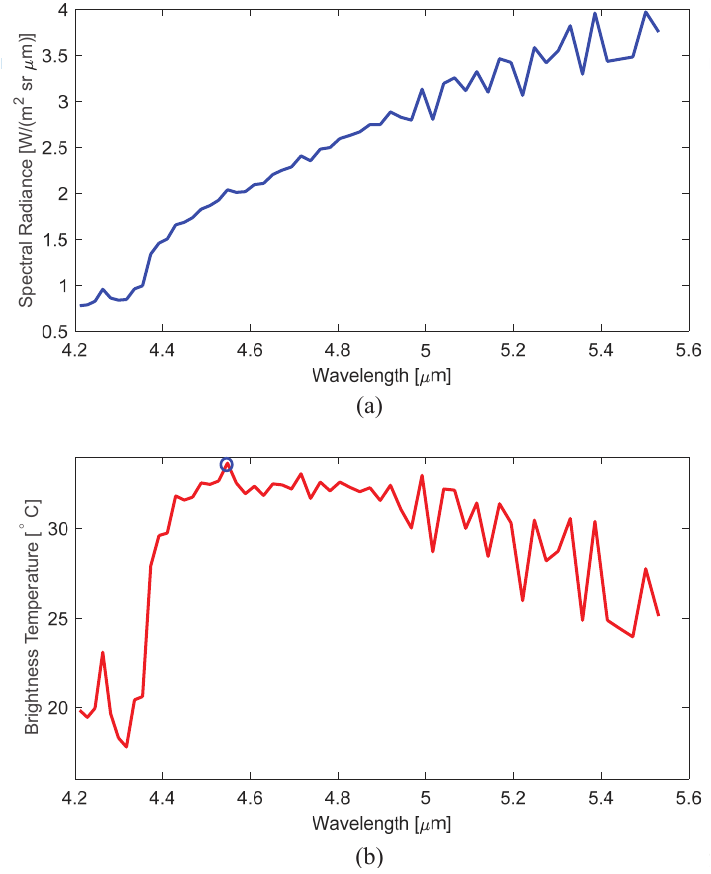
Figure 6. Example of brightness temperature extraction from spectral radiance: ( a ) the observed sample spectral radiance [W/(m 2 sr µ m)], and ( b ) the converted brightness temperature [ ◦ C]. T air separation module: According to the MODTRAN simulation in the MWIR band, the spectral transmittance of the carbon dioxide (CO 2 ) band (4.20–4.35 µ m) decreases abruptly with distance [21]. The average transmittance in the CO 2 band is 0.13, 0.03, 0.005, 0.0001, and 0 at 5 m, 10 m, 20 m, 50 m, and 100 m, respectively. Figure 7 demonstrates the atmospheric transmittance at the 50 m distance in the upper MWIR band. Note that the atmospheric transmittance is 0.0001 in the CO 2 absorption band. If we consider only the CO 2 band ( λ CO = [4.20–4.35 µ m]) with a minimum 20m object distance, transmittance 2 ) can be regarded as 0, which leads to Equation (7) derived from Equation (5). τ ( λ CO 2 An MWIR-FTIR camera receives only the upwelling of path thermal radiances in the λ CO 2